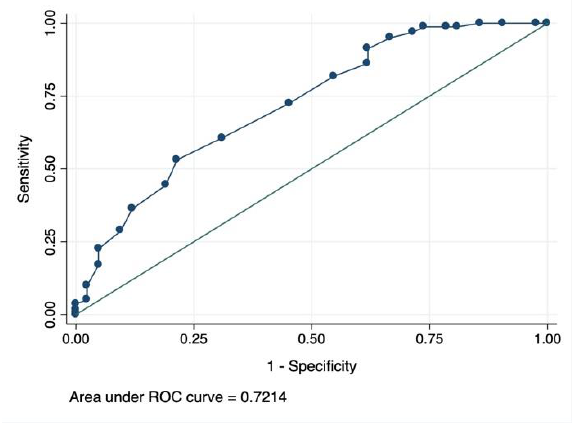
Figure 1. Area under ROC curve for the outcome of mortality with albumin.